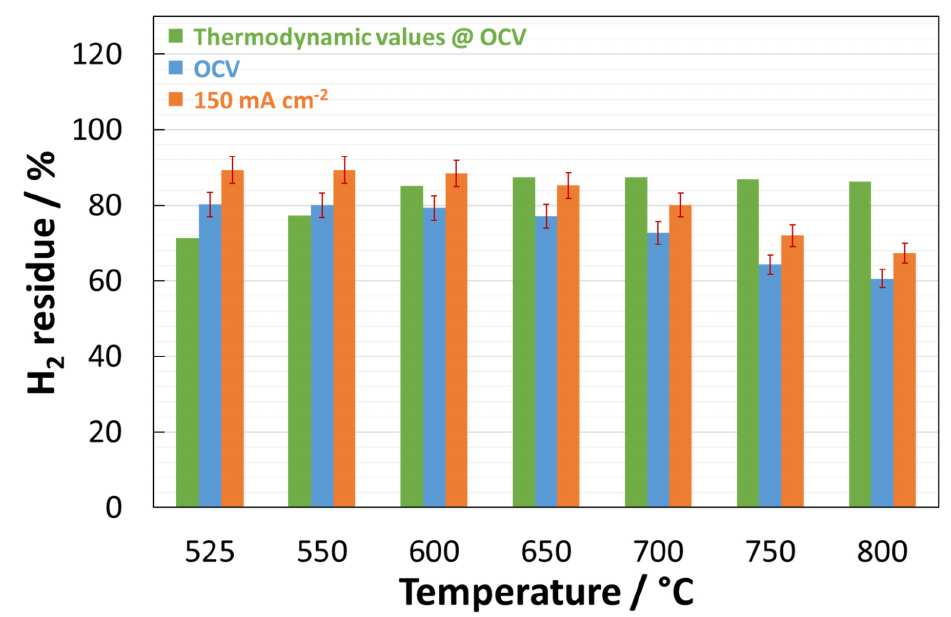
Figure 3. Trend of H 2 residue based on thermodynamic prediction and under practical conditions treated according to Equation (4).